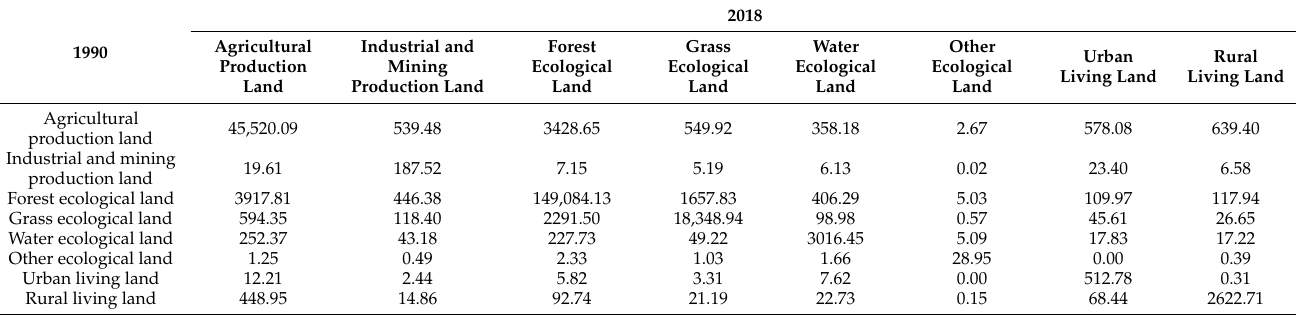
Table 3. Land use transfer matrix (km 2 ) of PLES in Guangxi, China, during 1990–2018.